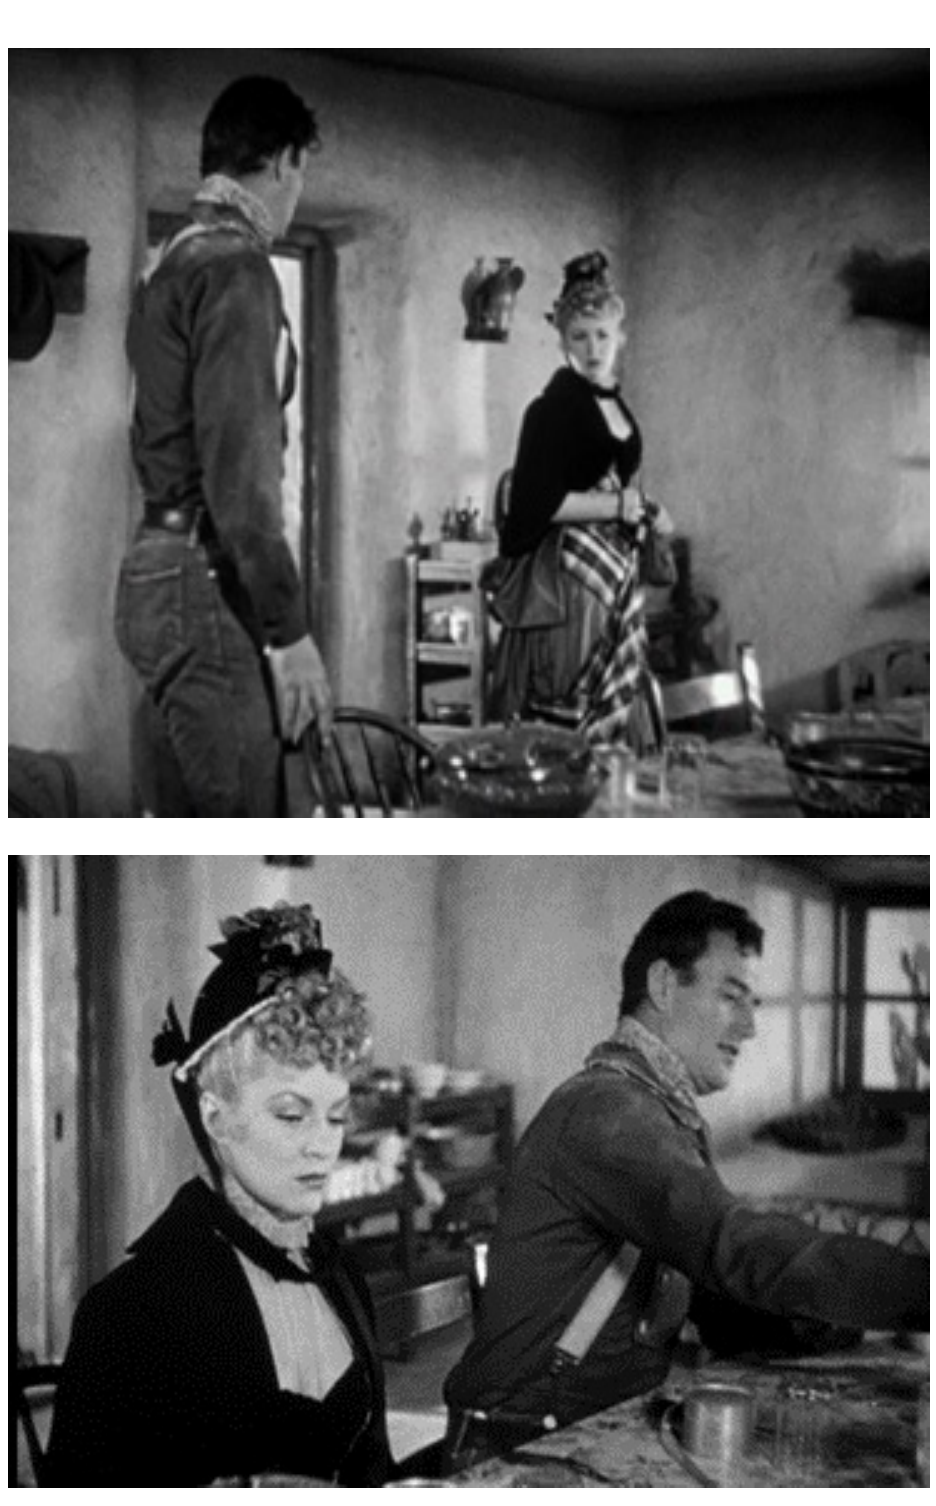
Figure 4: Dallas reluctantly accepts Ringo’s socially ignorant